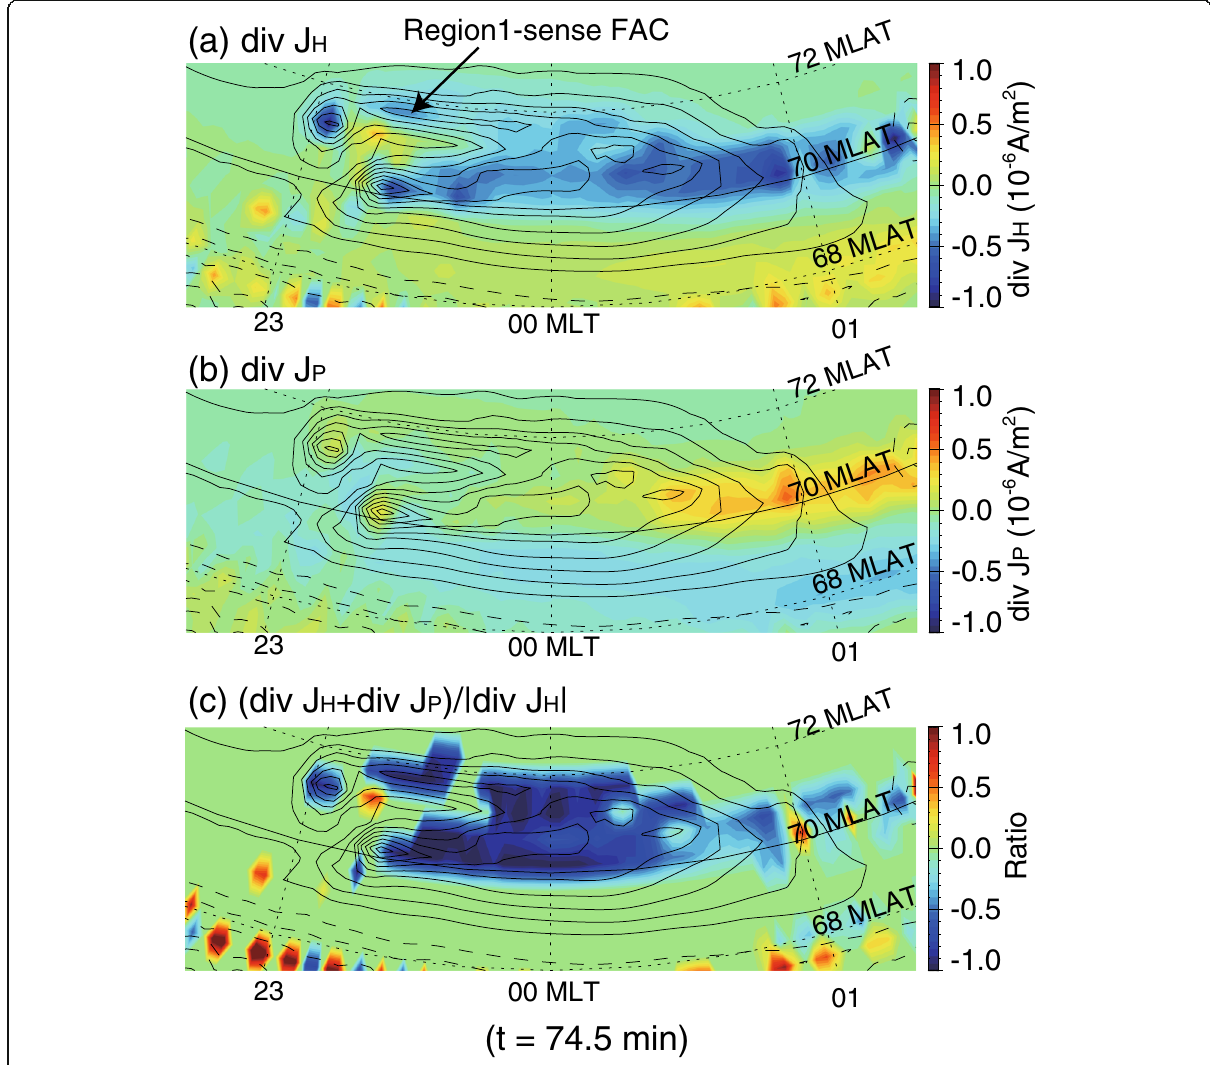
Fig. 13 a Divergence of the Hall current J H , b divergence of the Pedersen current J P , and c the ratio (div J H + div J P )/|div J H | (= − div J || /|div J H |). The contour lines indicate the field-aligned current with an interval of 0.05 μ A/m 2 . (Adapted from Ebihara and Tanaka